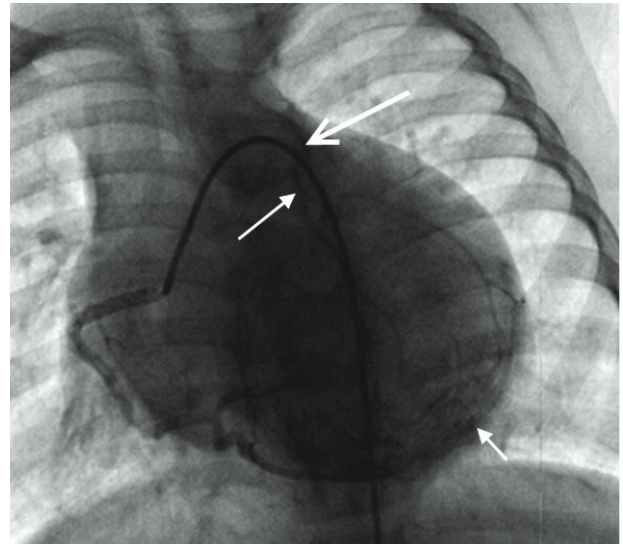
Fig. 3. Selective catheterisation of the right coronary artery. Multiple collateral vessels are present (smallest white arrow) which drain into the left coronary artery (arrow to the left of catheter) and into the main pulmonary artery (largest white